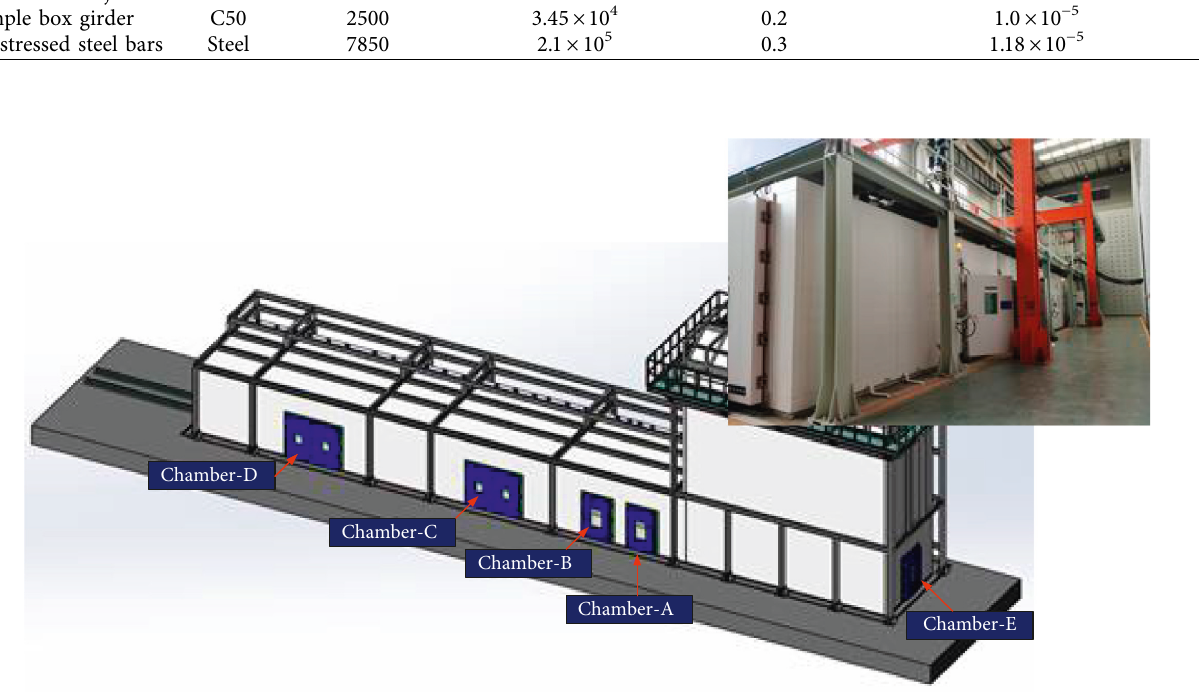
Figure 3: The environment device.